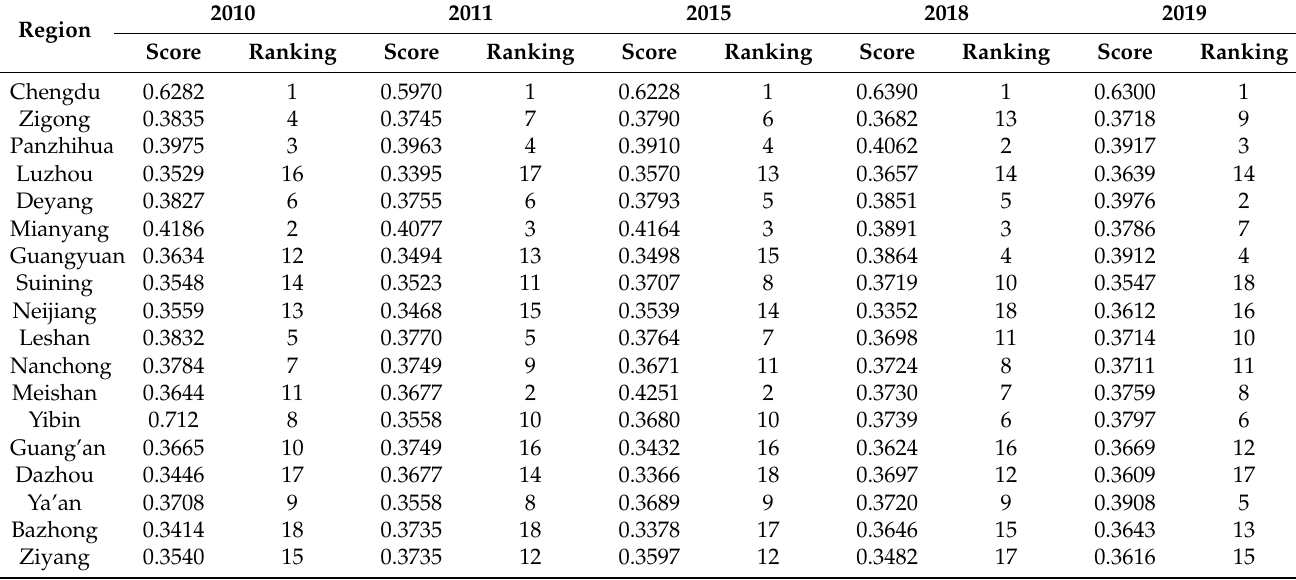
Table 5. Changes in the development of city–industry